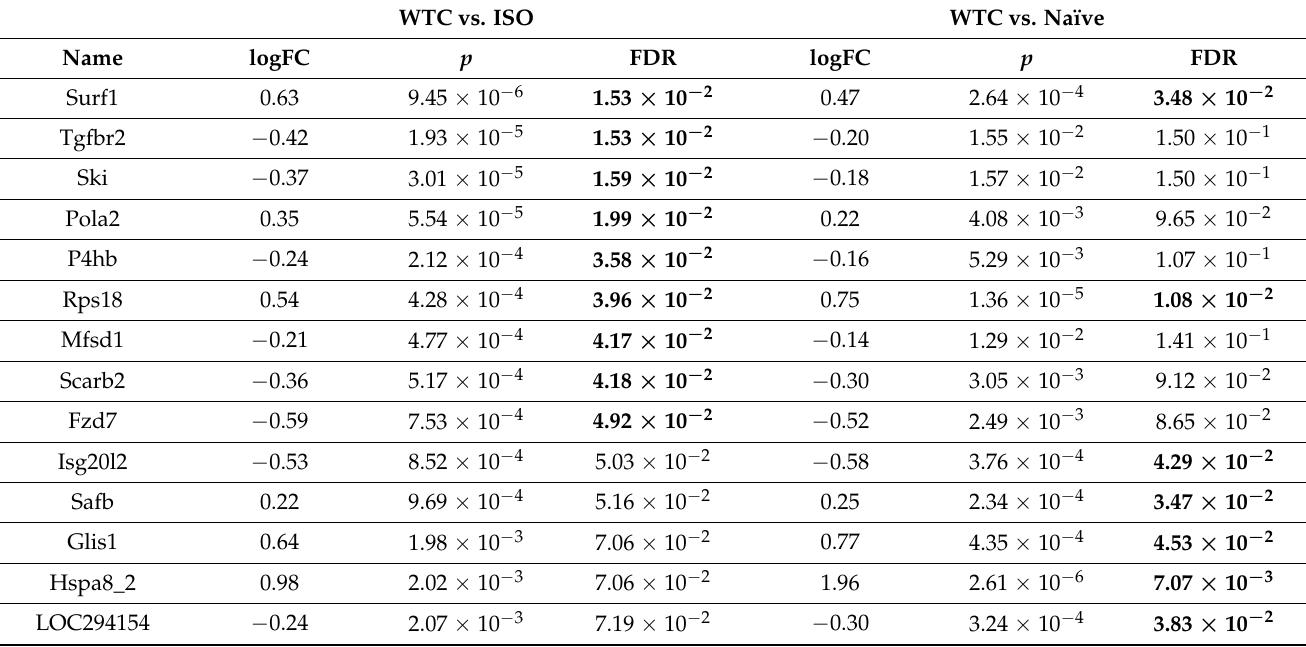
Table 1. The list of 14 DEGs reflecting attributable WTC effect on day 360. WTC vs. ISO WTC vs.